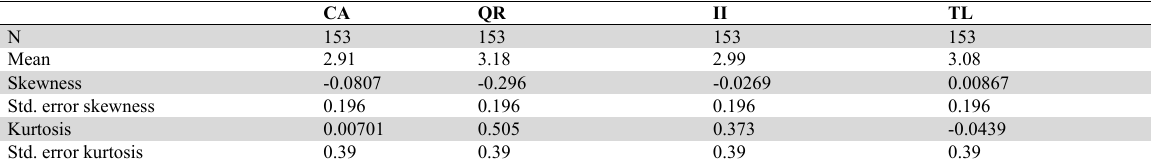
Mean, Kurtosis & Skewness of Constructs (N = 153)